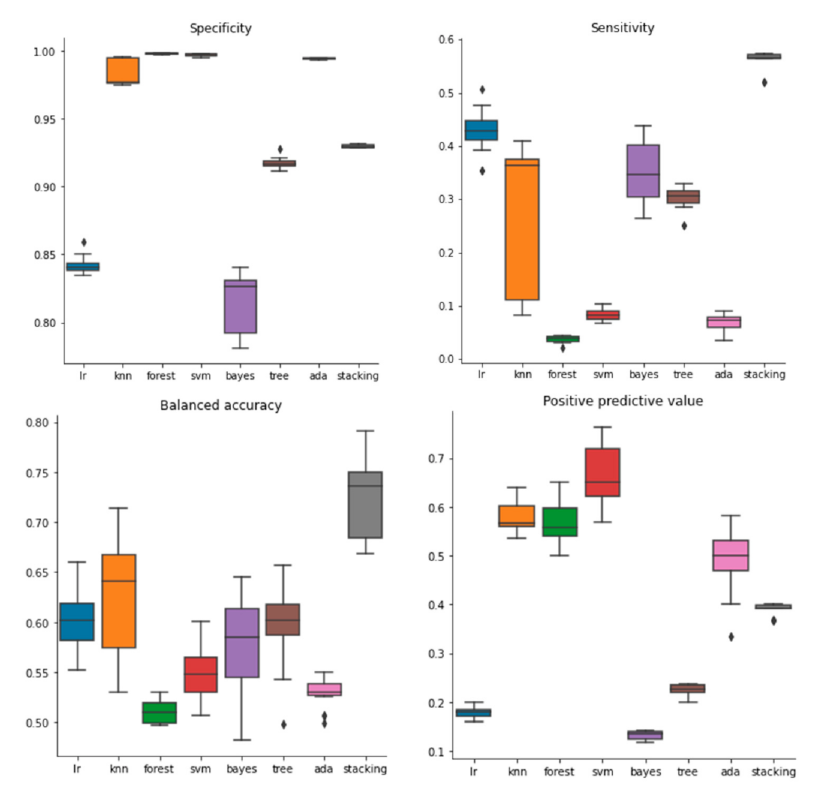
Figure 2. Performance of individual QSAR models and meta-model in the nested-cross